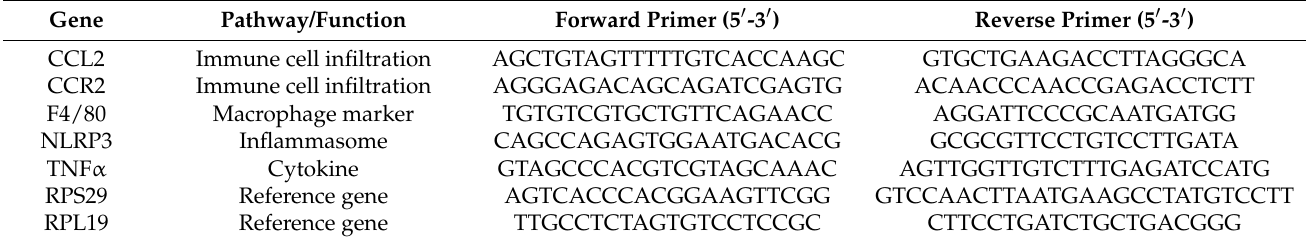
Table 1. Primers used for